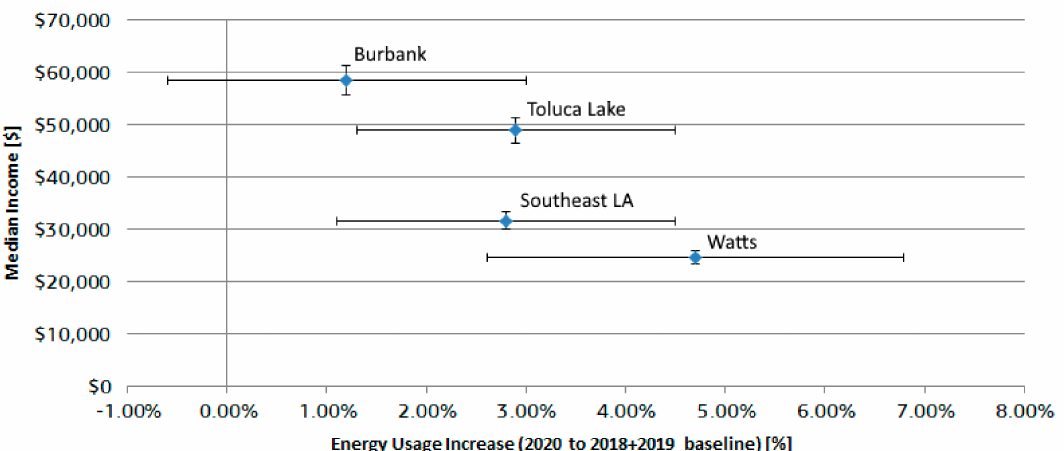
Figure 6. Energy change compared to feeder service community median income with a consistent 5% shown in the vertical error bars and the 80% CI shown in the horizontal error bars. The analysis scope was the COVID-19 pandemic period of Mid-March through